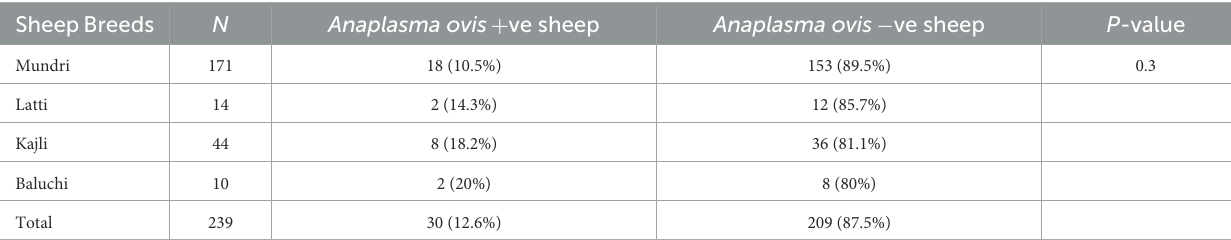
TABLE 1 Comparison of Anaplasma ovis prevalence in blood samples of various sheep breeds enrolled from District Dera Ghazi Khan during present study. Sheep Breeds